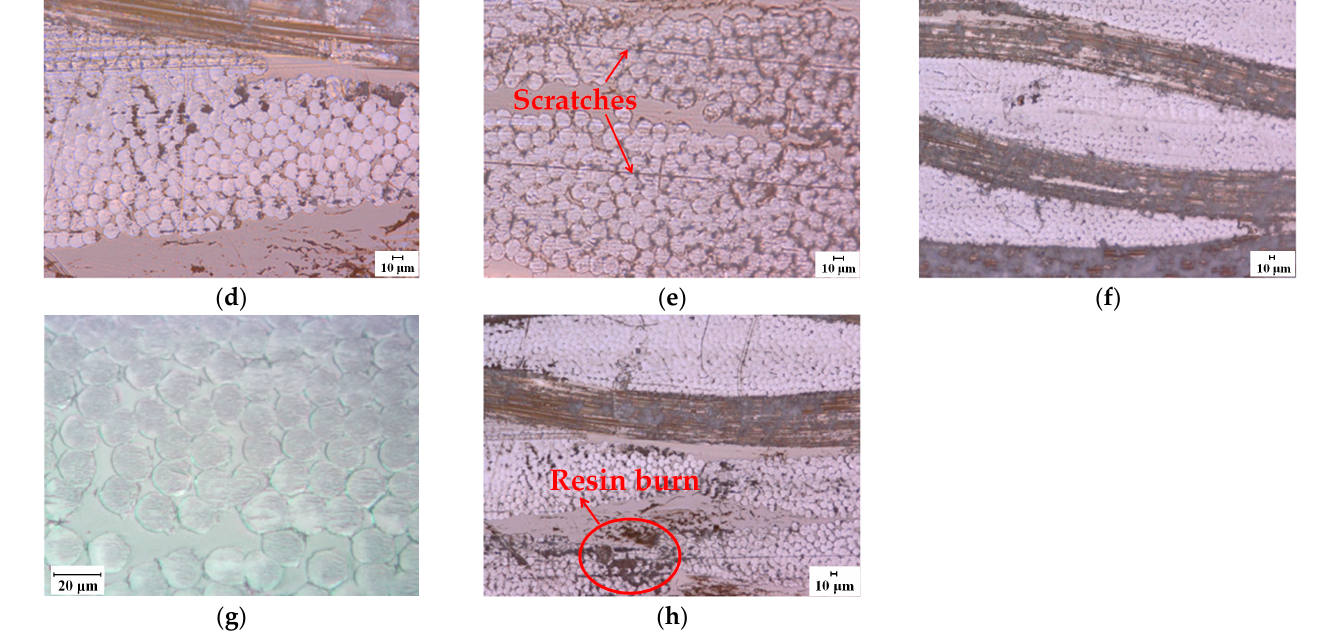
Figure 7. Surface morphology of AFRP composites after dicing. ( a ) Morphology of the groove side; ( b ) three-dimensional topography of the groove; ( c ) morphology of No.9 experiment; ( d ) morphology of No.10 experiment; ( e ) morphology of No.11 experiment; ( f ) morphology of No.12 experiment; ( g ) fracture morphology of fibers; ( h ) morphology of No.16 experiment.